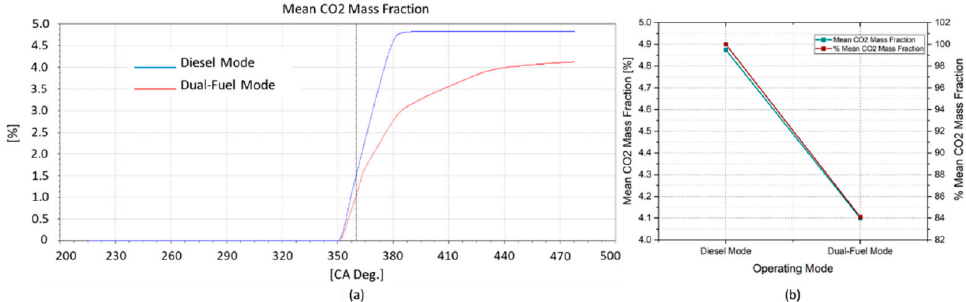
Figure 17. The mean CO 2 mass fractions ( a ) and CO 2 emission masses ( b ) in both combustion